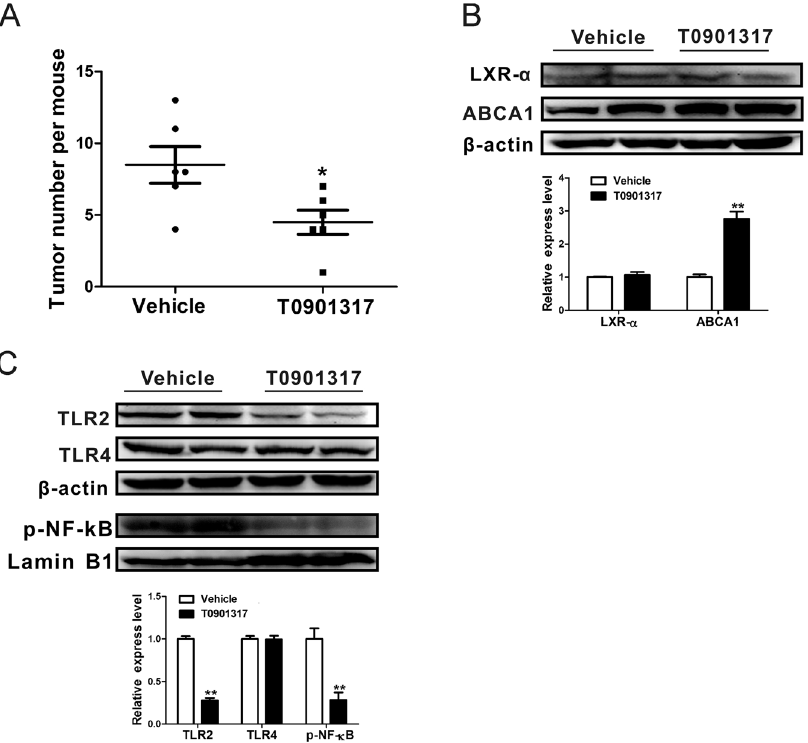
Figure 5. Intranasal administration of LXR agonist T0901317 attenuates urethane induced lung carcinogenesis in ND-fed C57BL/6J mice. ( A ) Tumor numbers in vehicle or T0901317 treated C57BL/6J mice lungs harvested at experimental week 28 (n = 6 per group). Dots indicate raw data points; lines, mean; bars, SEM. ( B , C ) Western blotting for the expression of LXR- α , ABCA1, TLR2, TLR4 and phosphorylated NF- κ B p65 in vehicle or T0901317 treated C57BL/6J mice lung tissues collected at experimental week 13. β -actin and Lamin B1 were used as the internal cytoplasma or nuclear protein control, respectively. Representative two mice results in each group and cropped gels/blots were displayed in the photos. Densitometry quantification was analyzed among 3 mice per group using Image J